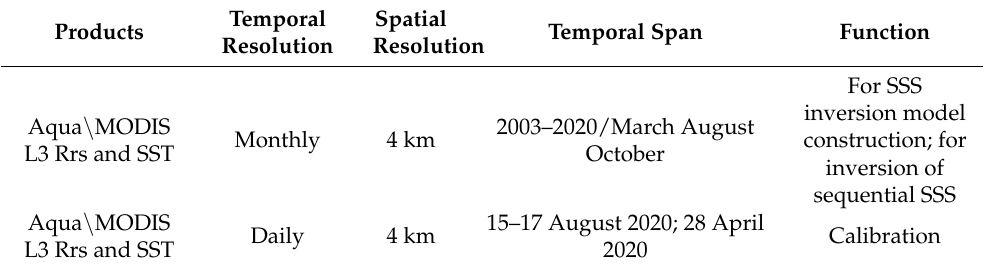
Table 1. List of satellite products used in this study and their